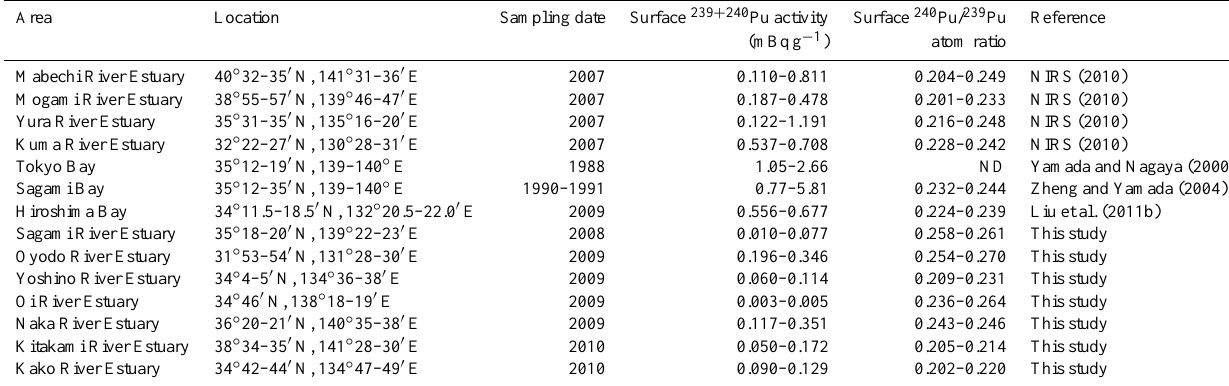
Table 1. Summary of the distributions of 239 + 240 Pu activity and 240 Pu/ 239 Pu atom ratio in the surface sediments (0–2cm) from Japanese estuaries.